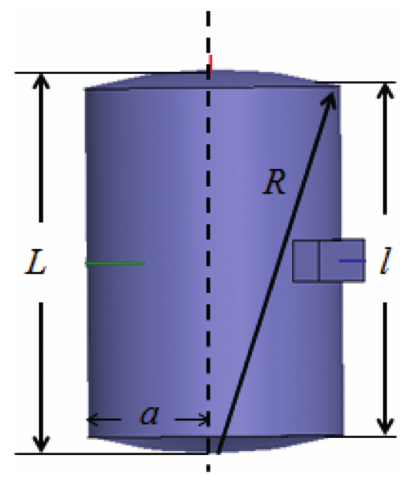
Figure 1: The model of the novel quasi-optical microwave multimode